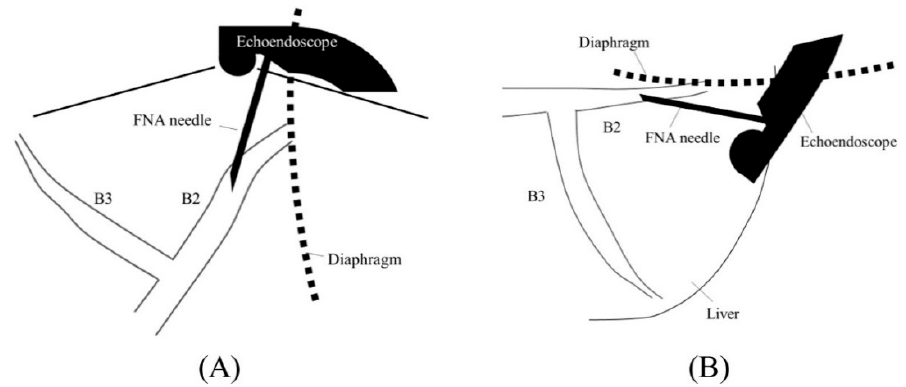
Figure 6. Optimal echoendoscope position in B2 puncture. Pushing a scope while turning the large wheel upward facilitates transgastric and reliable bile duct puncture (( A ); ultrasound image, ( B ); fluoroscopic image).